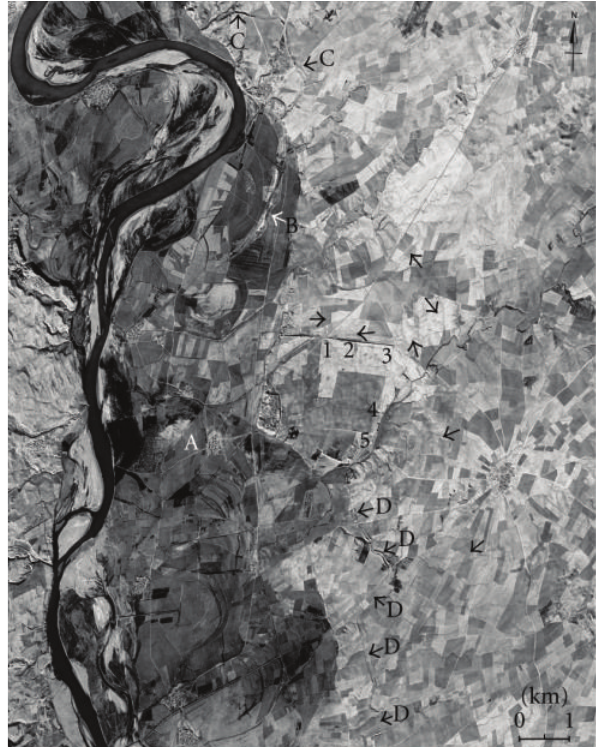
Figure 8: Kalhu and the surrounding territory in a Corona KH-4B photo of 1969: (A) Tigris valley and traces of paleo-river beds; big arrows show traces of ancient roads, while small arrows point traces and remains of ancient canals (B, C, and D); 1–5, gates along the city